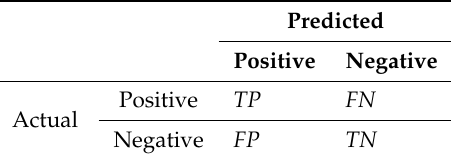
Table 2. Confusion